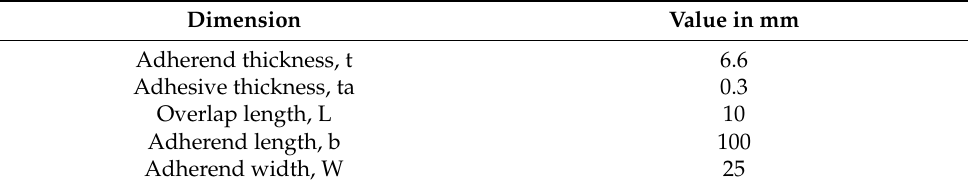
Figure 1. Single lap joint geometry. Table 2. Single lap joint dimensions.